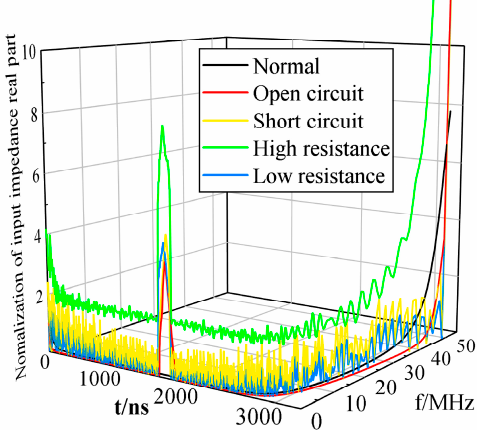
Figure 8. Headend input time–frequency domain impedance of the real part of the spectrum of normal operation and fault cables.